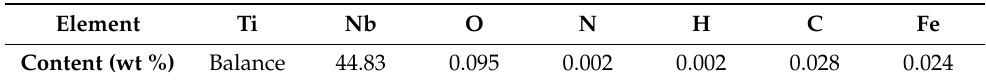
Table 1. Chemical composition of the Ti-45Nb alloy. Element Ti Nb O N H C Fe Content (wt %) Balance